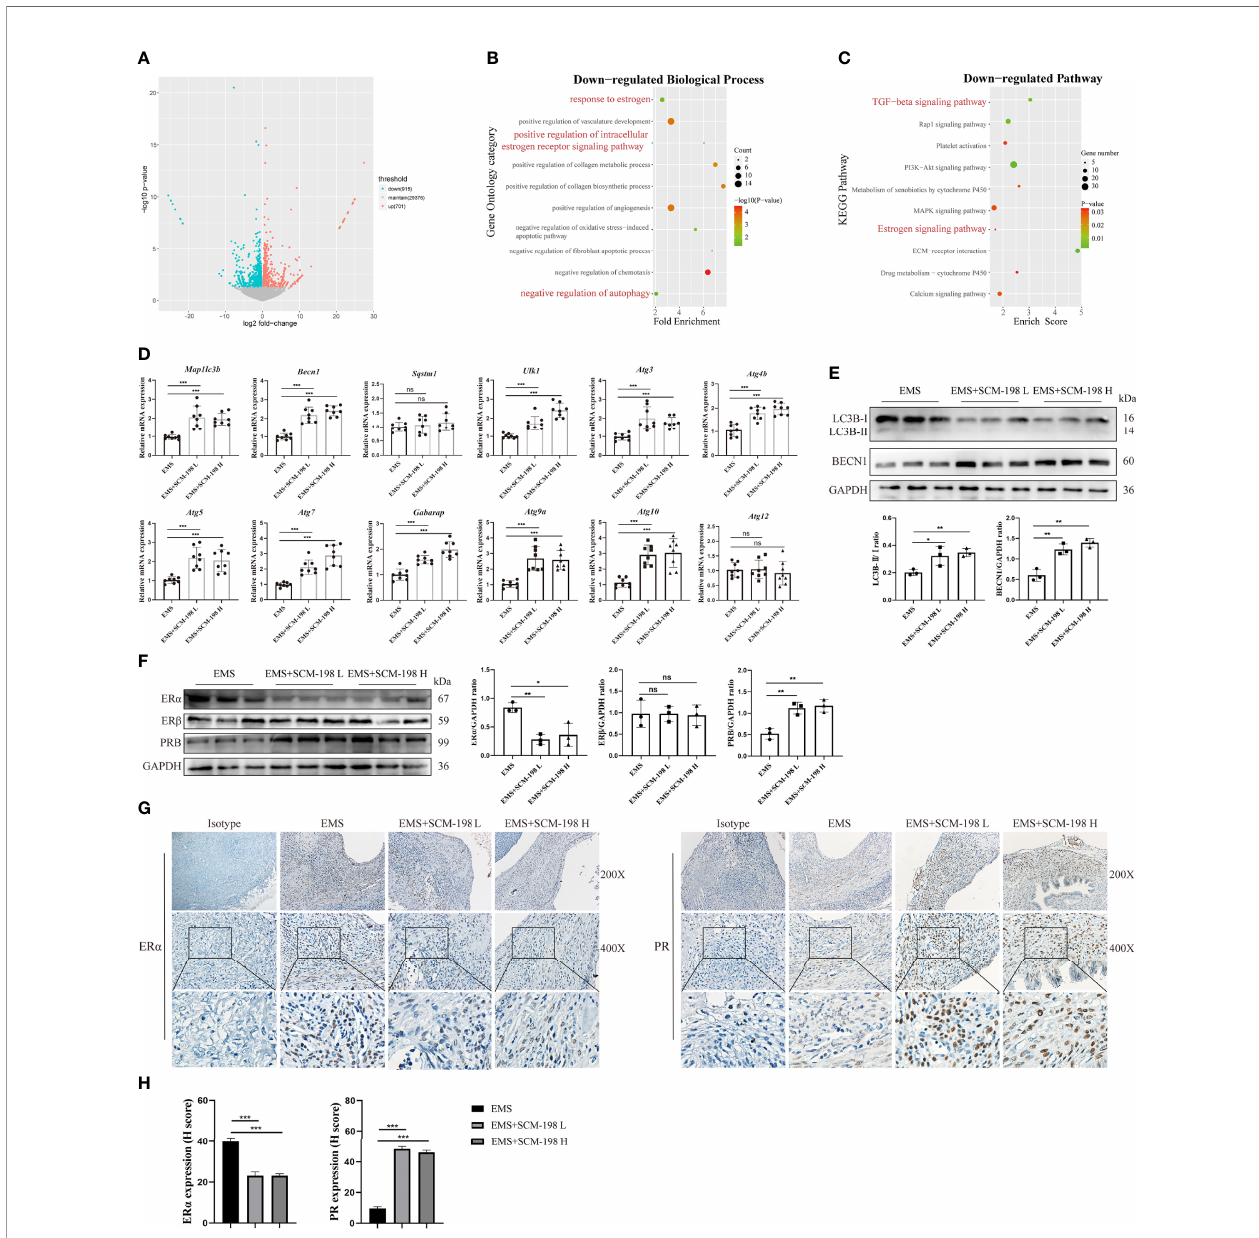
FIGURE 2 | SCM-198 promotes the autophagy level and reverses the ER a /PR imbalance of EMS (A) A volcano plot of differentially expressed genes of ectopic lesions in SCM-198-treated EMS mice compared with those from the untreated EMS mice. The x-axis shows the Log2 (fold change) in expression, and the y-axis shows the -Log10 ( P -value) of the gene being expressed differentially (blue: downregulated genes; red: upregulated genes). (B) GO enrichment of biological process for the downregulated genes. (C) The KEGG pathway analysis of the downregulated genes. (D) The mRNA expressions of Map1lc3b, Becn1, Sqstm1, Ulk1, Atg3, Atg4b, Atg5, Atg7, Gabarap, Atg9a, Atg10, and Atg12 of the ectopic lesion (n = 8) treated with or without SCM-198. (E, F) The protein expressions of LC3B-II/I, BECN1, ER a , Er b , and PR in ectopic lesions were measured via Western blotting (n = 3). (G, H) The representative IHC images and quanti fi cation data of ER a and PR expressions in ectopic lesions. Data are presented as the mean ± SD (* P < 0.05, ** P < 0.01, and *** P < 0.001; ns, not signi fi